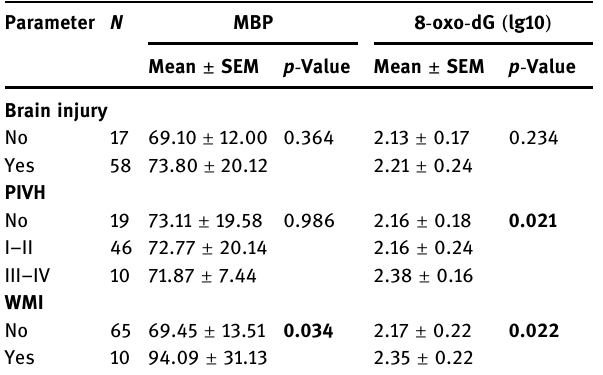
Figure 2: ROC curve analysis of MBP and 8 - oxo - dG in